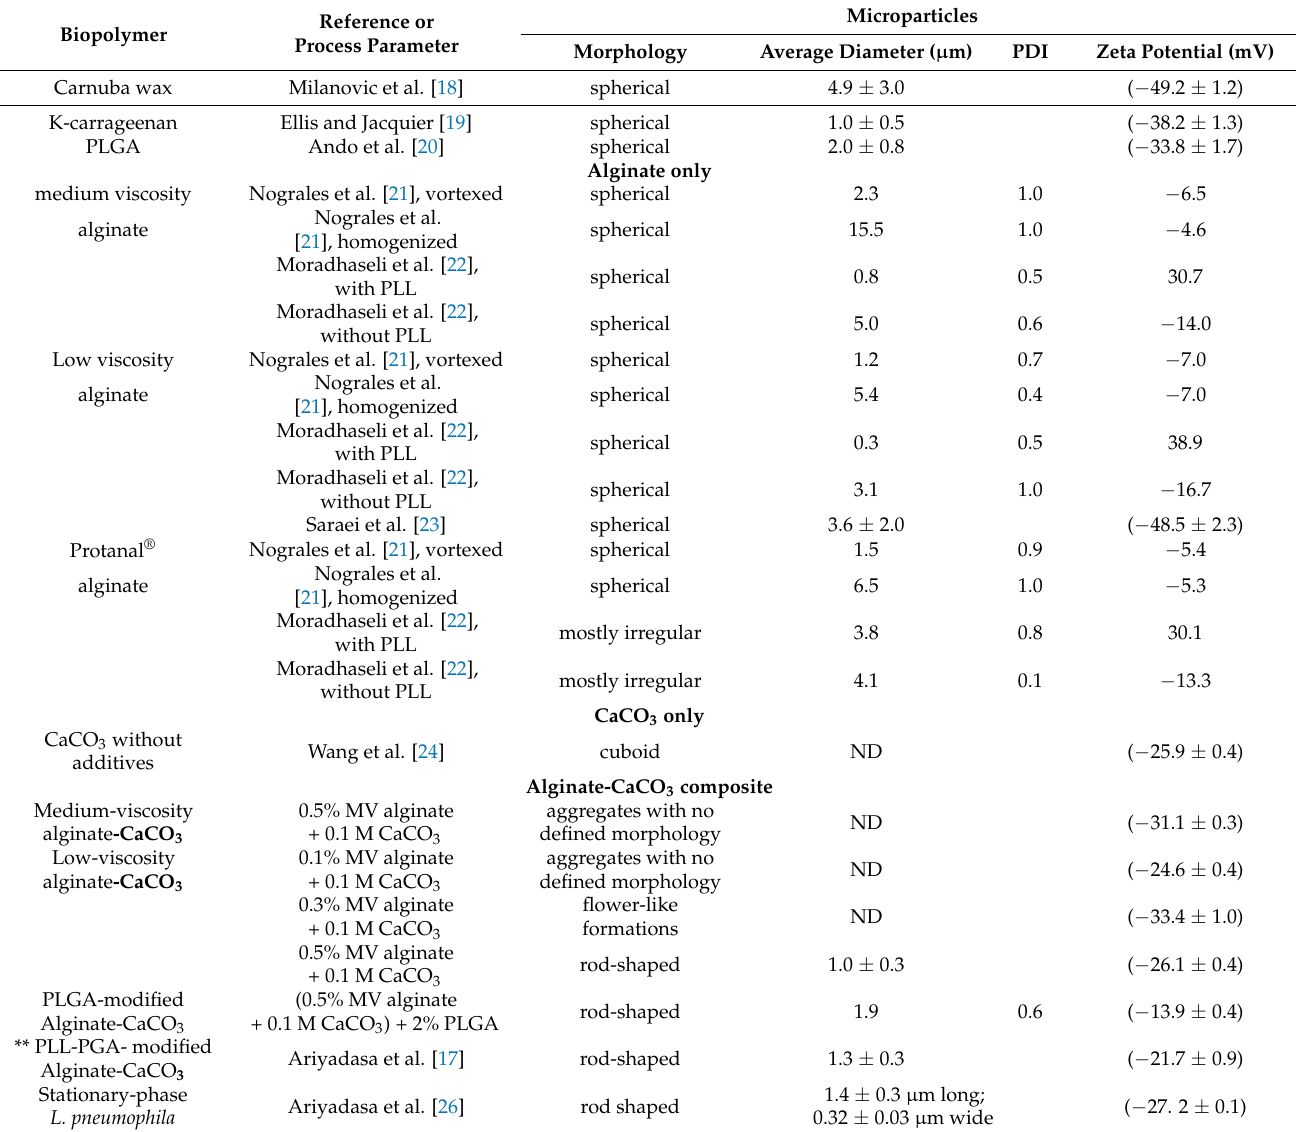
Table 1. Summary of morphologies, average diameters, and zeta potentials of the microparticles synthesized using the selected